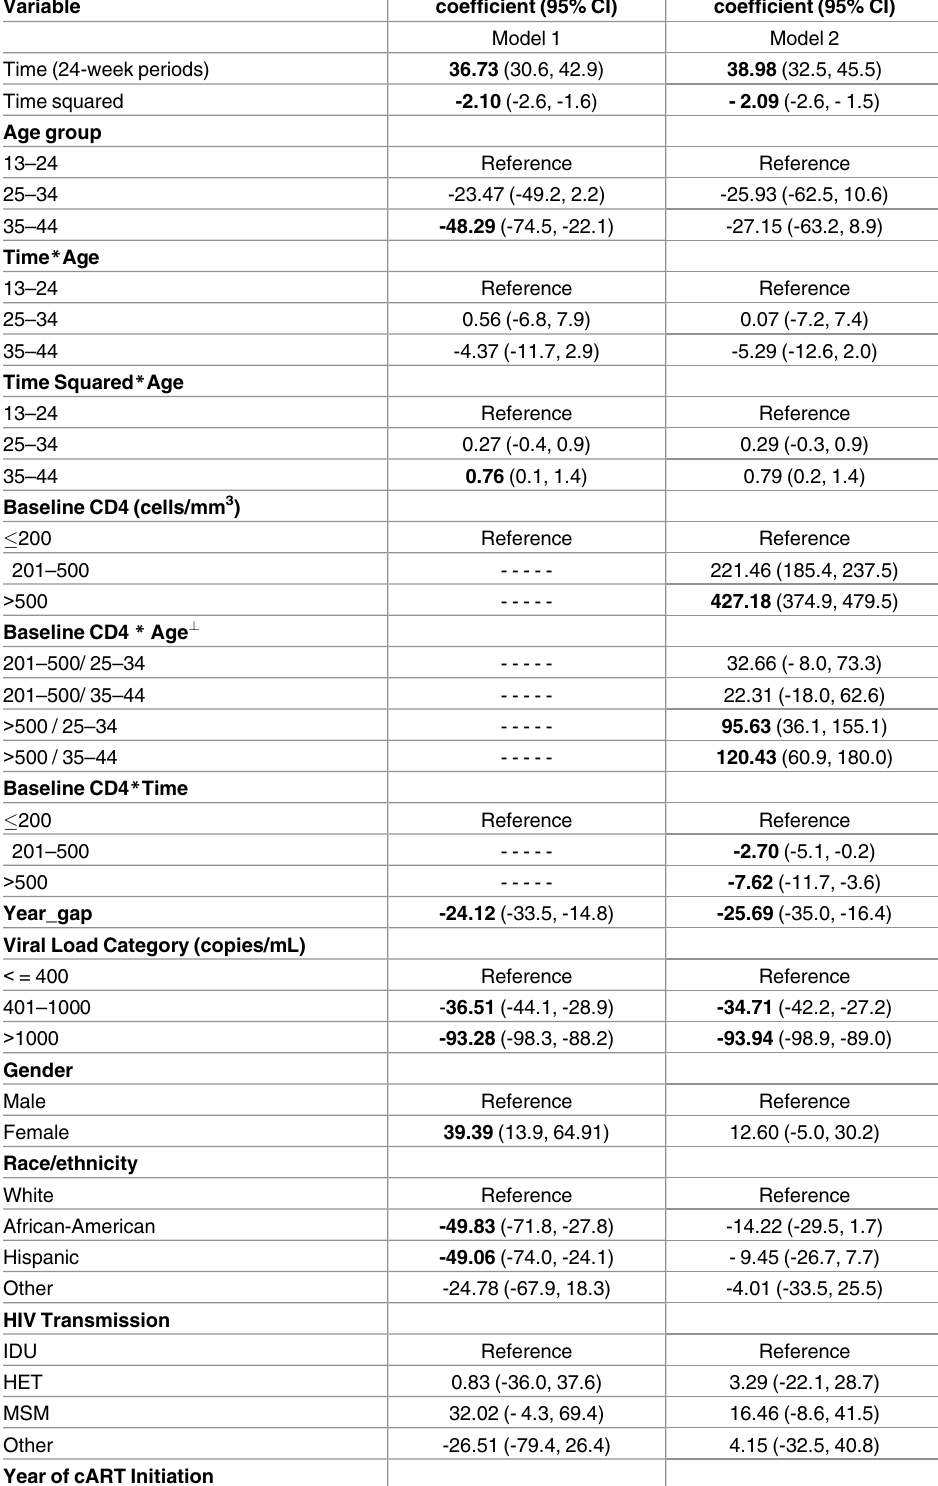
Table 2. Mixed-model Regression Analysis of CD4